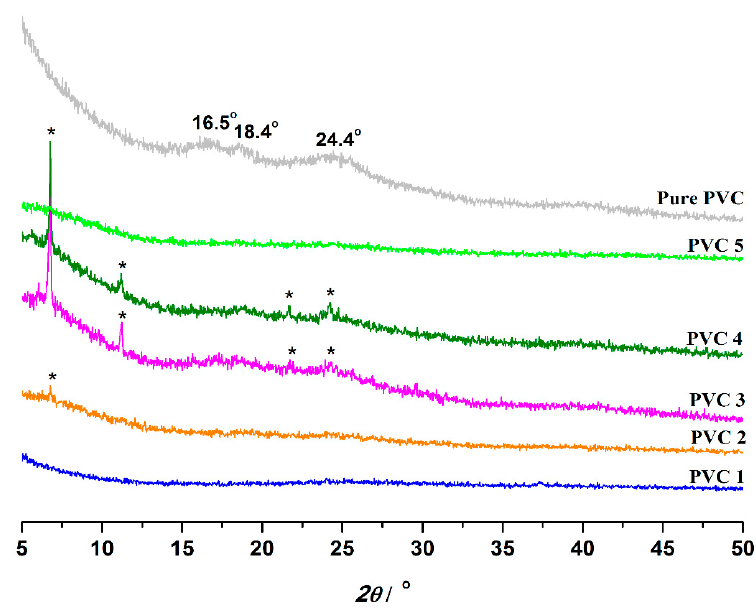
Figure 3. X-ray di ff ractograms of all DEHF / DEHT-based PVC films and pure PVC. * indicates the zinc Figure 3. X-Ray diffractograms of all DEHF/DEHT-based PVC films and pure PVC. * indicates the stearate di ff raction zinc stearate diffraction peaks.